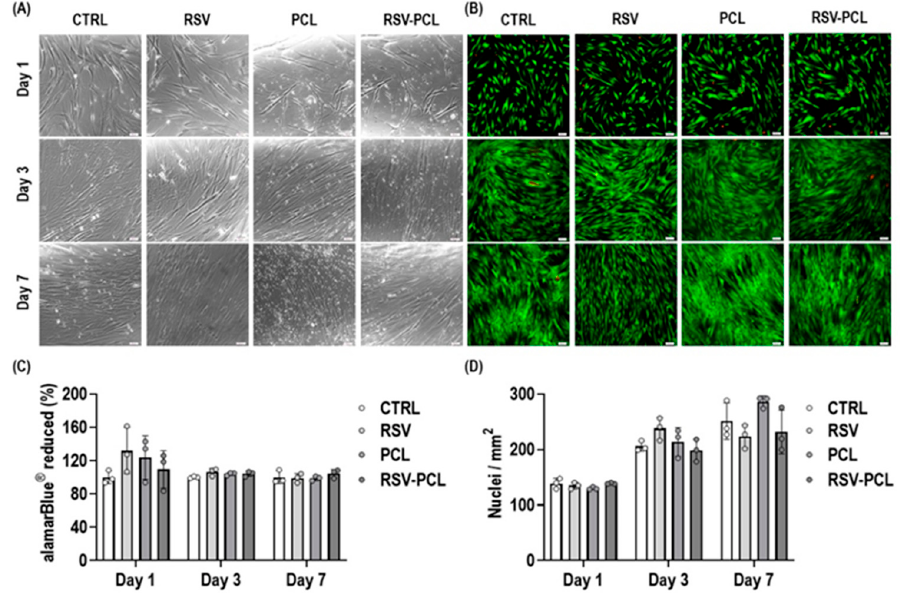
Figure 4. Biocompatibility analysis of 0% RSV-PCL (PCL) and 10% RSV-PCL (RSV-PCL) electrosprayed microparticles on human dermal fibroblasts. Cell attachment ( A ), Live/Dead viability assay (live: green, dead: red. Scale bars: 100 μ m) ( B ), alamarBlue ® measure of metabolic activity (results normalized to untreated control, CTRL, at each time point, Scale bars: 100 μ m) ( C ), and proliferation ( D ) were not affected by PCL and RSV-PCL (100 μ g/mL) microparticles as a function of time (1, 3, and 7 days) ( n = 3). Media containing 5 μ M RSV was used as a positive control. Individual values are displayed as dots on bar charts. Error bars represent mean ± SD. Generalized linear models and bootstrap- t -tests.